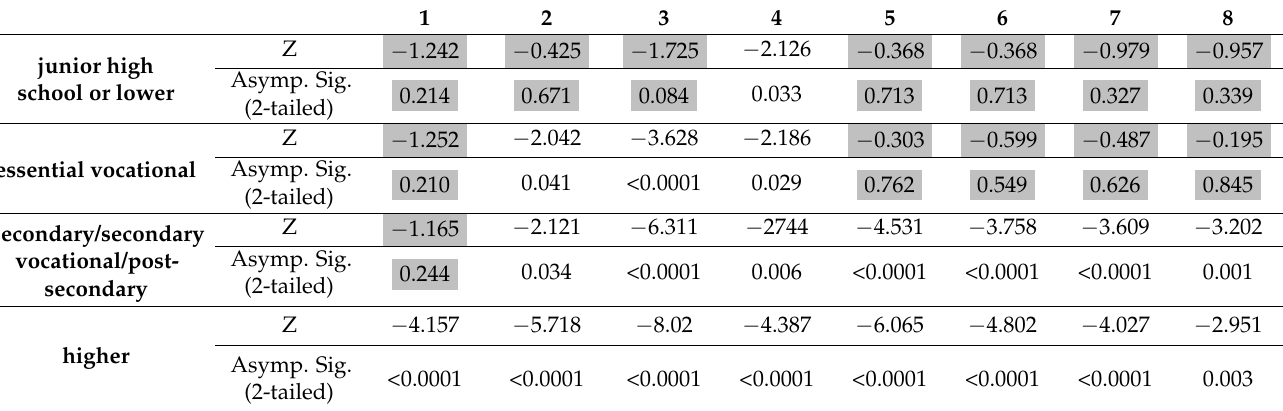
Table 9. Education-based consumer